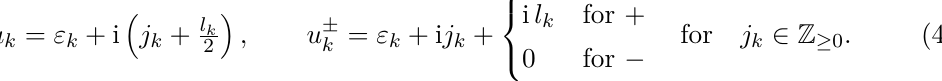
Figure 3 . A graphical depiction of the eight regions of the W 2 the { j 1 , j 2 } -plane, parametrized by the helicities { l 1 , l 2 } and listed in table 7. u = i( j + l k ) are collected. Following the ideas of [27, 32], we first change the variables k k 2